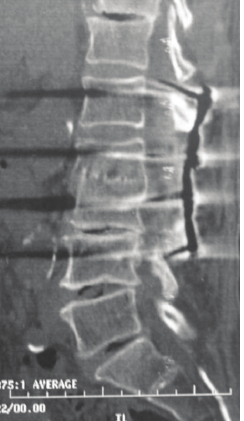
Figure 4: CT scan at the 5-year followup confirming bony union achievement and a solid and stable fusion of the spine (Case 1).